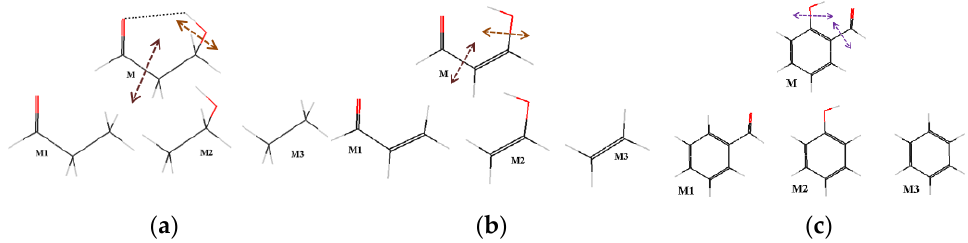
RAHB ( a ), RAHB ( b ), and arom ‐ AHB ( c ).